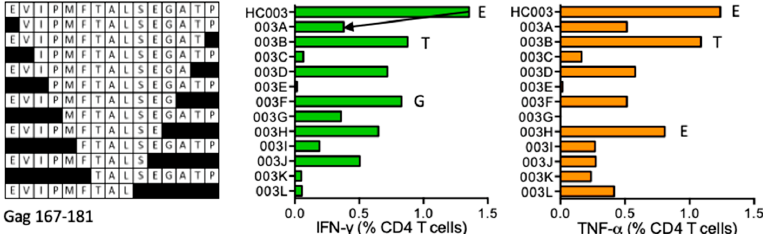
Figure 2. HC003/VID 418—definition of CD4 + T-cell epitopes in HIV-1 protein Gag. Cryopreserved PBMC from vaccine recipient 418 were expanded by stimulation with ‘parental’ 15-mer responder peptide for 10 days to establish e ff ector STCL. These were subjected to ICS using serially truncated (left) and a positive CD4 + T-cell production of IFN- γ (green) and TNF- α (orange) was monitored. Arrows and